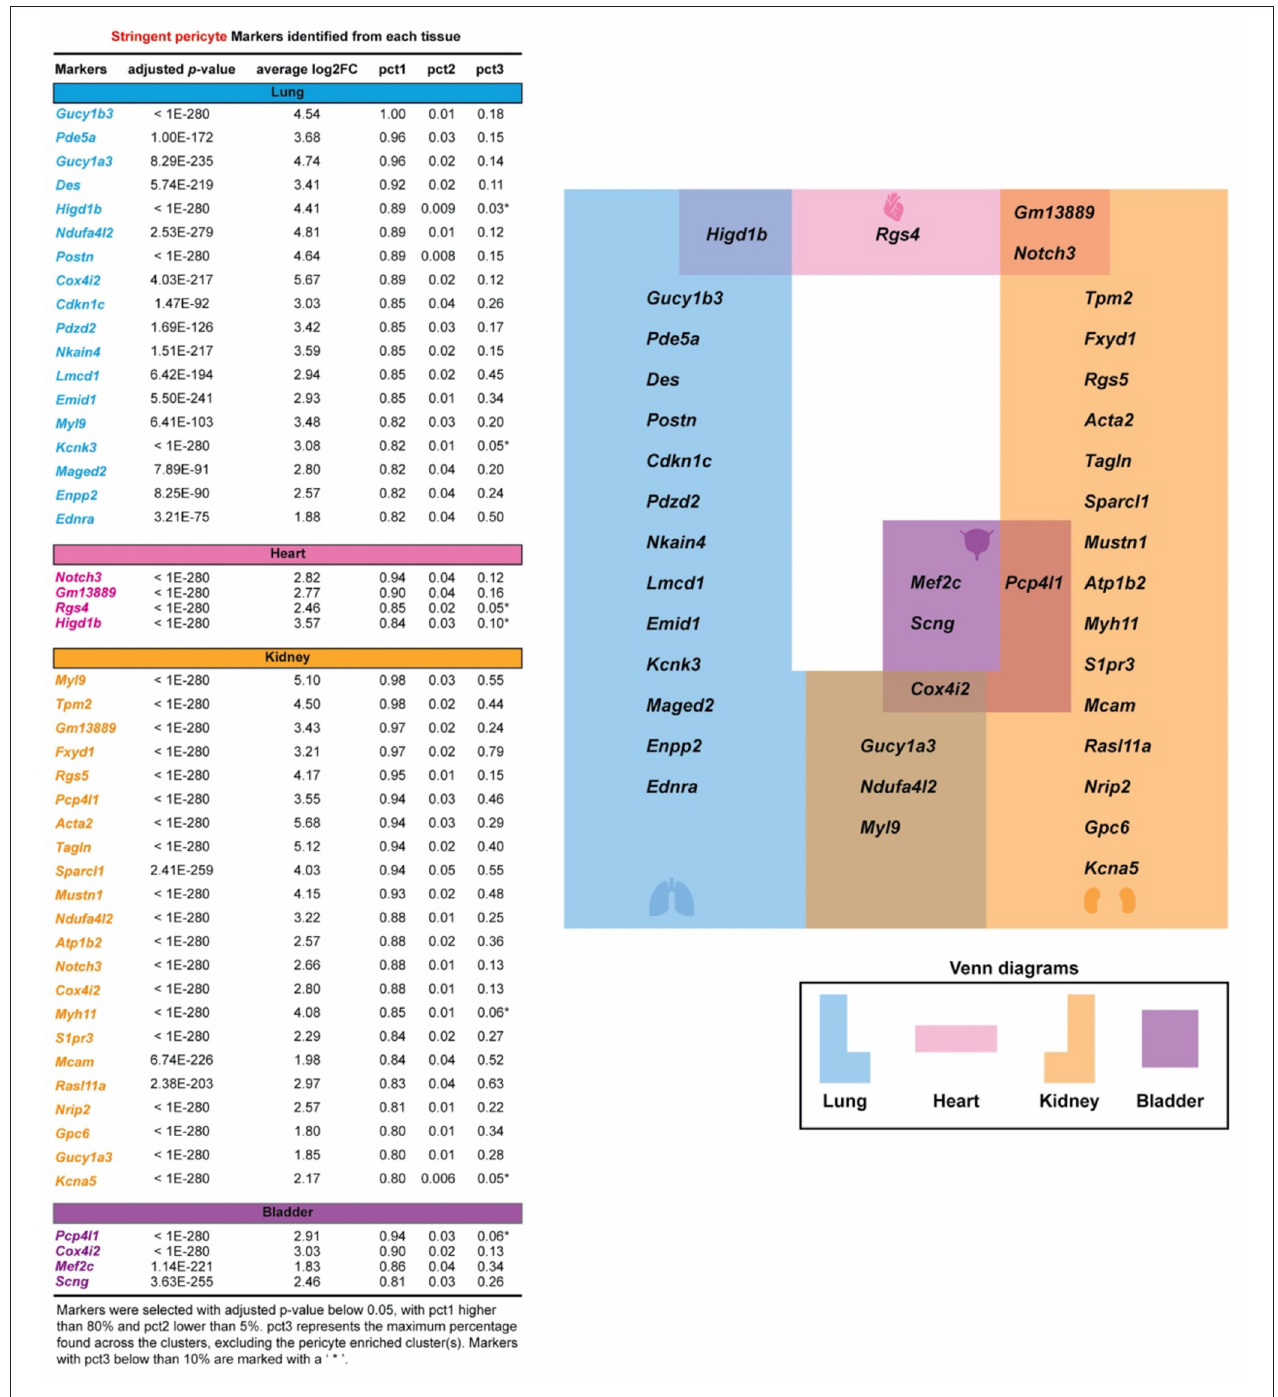
FIGURE 2 | Specific pericyte markers in four organs are identified. Potential pericyte markers for each tissue. Potential pericyte markers were selected based on the differential expression (DE) analysis using the Wilcoxon rank sum test to compare the expression levels of transcripts in the tissue-specific stringent pericytes vs. all other cells within the corresponding tissue. Pericyte-enriched transcripts with an adjusted p -value below 0.05 were selected. The subset of these transcripts detected in more than 80% of the stringent pericytes and in < 5% in all other cells were then chosen as potential pericyte markers for each tissue. pct3 represents the maximum percentage found across the clusters, excluding the pericyte-enriched cluster(s). Markers with pct3 below 10% are shown with an asterisk (*).